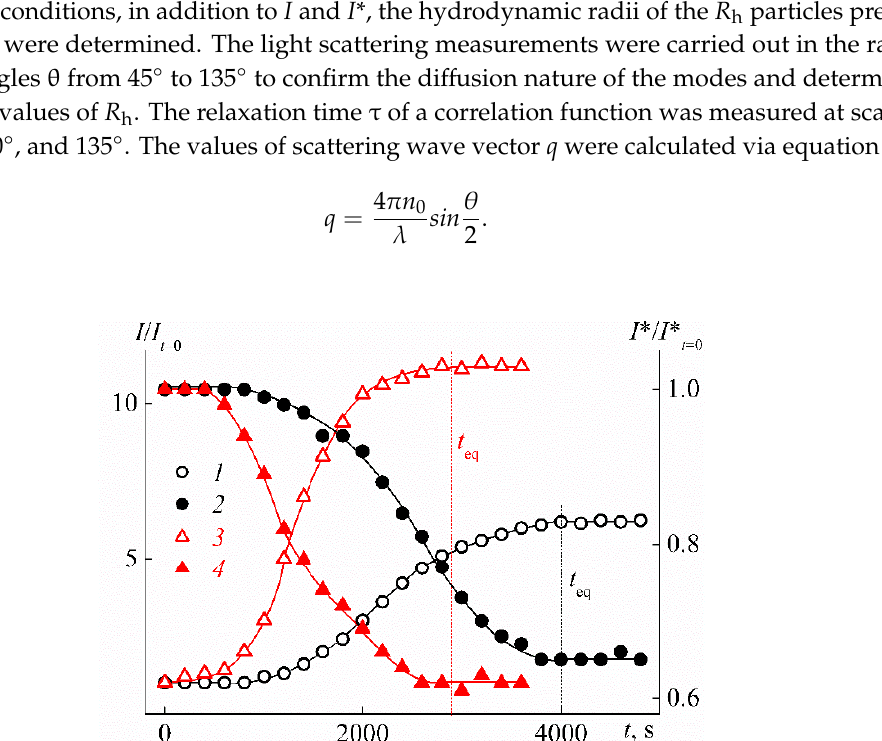
Figure 8. Dependencies of inverse relaxation times on the squared scattering wave vector for PEI-1 in water at 10 °С and 19 °С at c = 0.0374 g cm –3 .